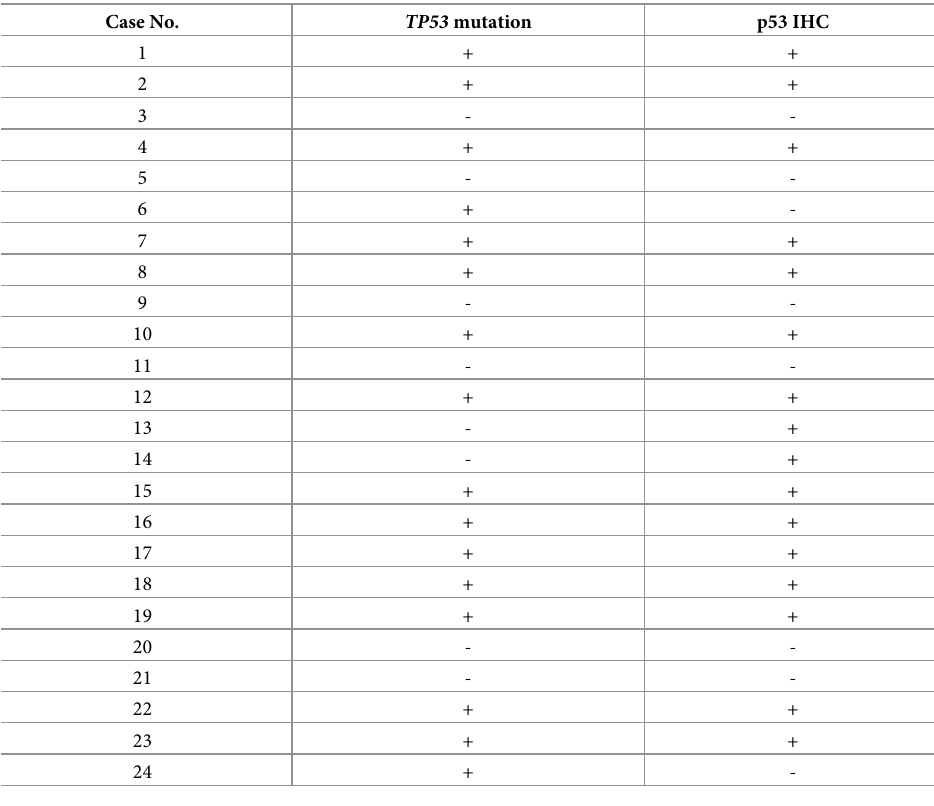
Table 3. Comparison between TP53 mutations and p53-antibody immunohistochemistry. Case